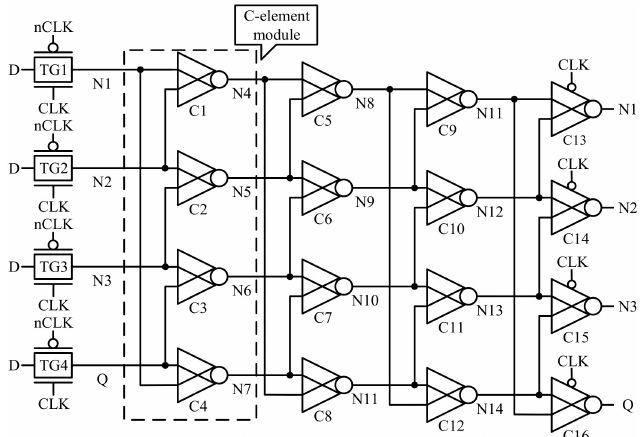
Figure 9. Proposed HTNURL latch